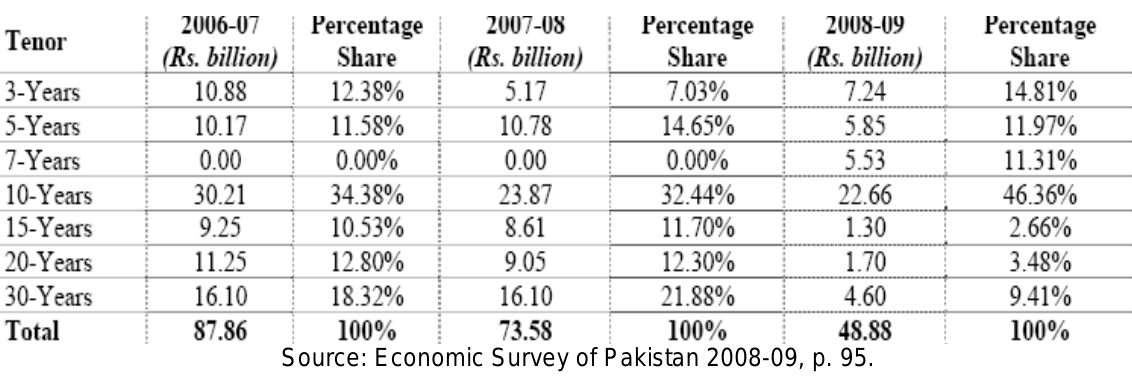
Table 2: Overview of Pakistan Investment